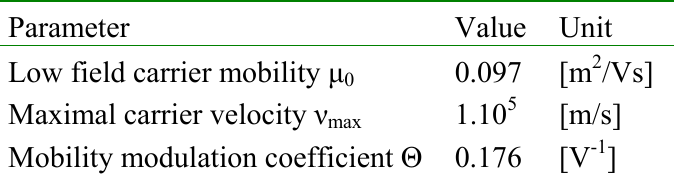
Table 1. Parameters of ISFET SPICE model.